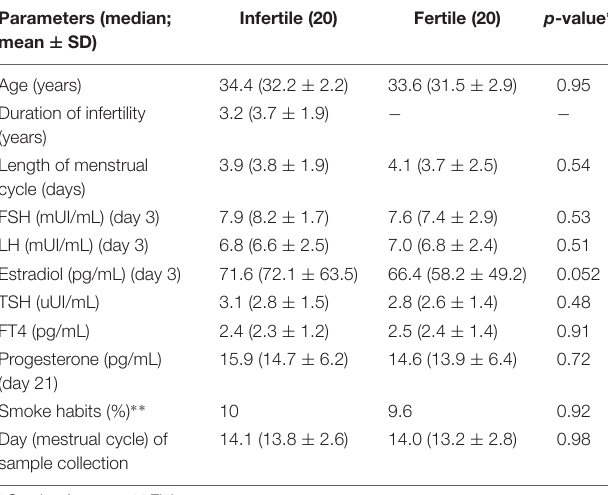
TABLE 1 | Women cohorts: demographical and clinical